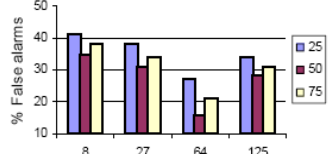
Fig. 8 False alarms of the method by varying window size and bins.